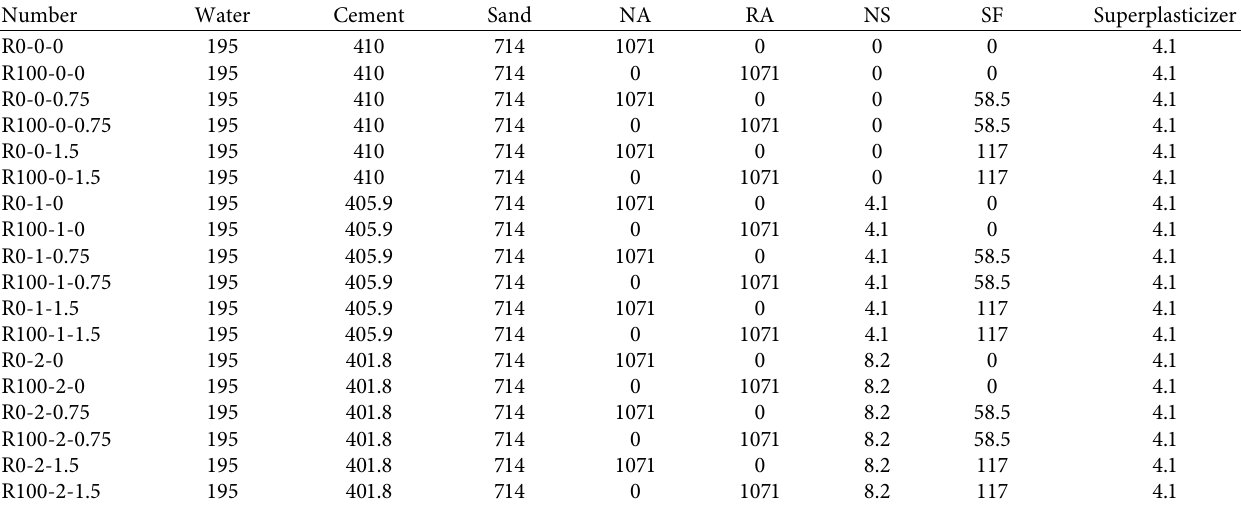
Table 4: Mix proportion of concrete (kg · m − 3